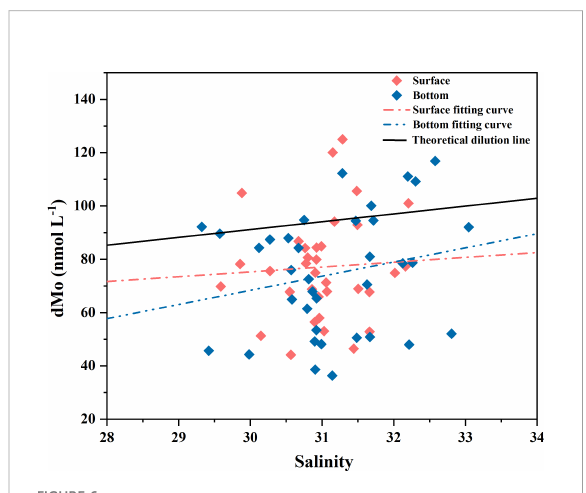
FIGURE 6 The plot of dMo against salinity in the BS and YS. Blue and red dots respect values in surface and bottom seawaters, respectively. The black line represents the theoretical mixing line between river water (dMo = 1 nmol L -1 ) and ocean water (dMo = 105 nmol L -1 ) at salinity of 35.